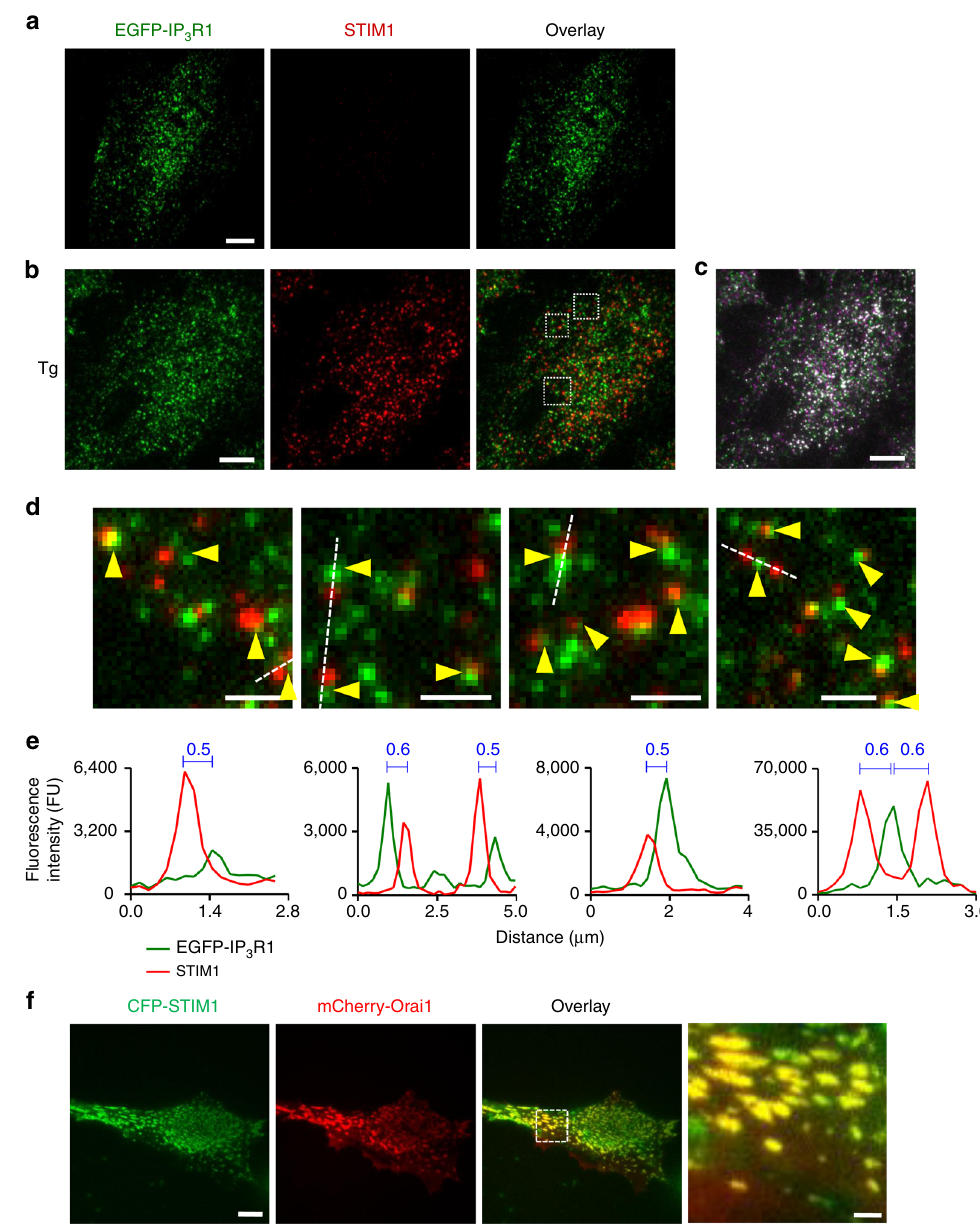
Fig. 7 Depletion of ER Ca 2+ stores causes native STIM1 to accumulate at functional ER-PM junctions adjacent to immobile IP 3 R puncta. a , b Representative TIRFM images of EGFP-IP 3 R1 HeLa cells fi xed and immunostained for STIM1 before ( a ) or after treatment with thapsigargin (Tg, 1 µ M, 15 min) to deplete the ER of Ca 2+ ( b ). Overlaid images of Tg-treated cells show no signi fi cant co-localization of STIM1 and IP 3 R puncta (Pearson ’ s coef fi cient with Costes ’ automatic threshold: 0.331 ± 0.026, n = 7 cells). c Distribution of mobile (green and magenta) and immobile (white) IP 3 R puncta in Tg-treated cell. Scale bars ( a – c ) = 10 µ m. d Enlargements of the boxed regions in b show that immobile IP 3 R puncta (identi fi ed before fi xation ( c ), with all shown by arrowheads) abut STIM1 puncta without coinciding with them. Scale bars = 2 µ m. e Fluorescence intensity pro fi les for EGFP-IP 3 R1 and STIM1 across the lines shown in d . Distances ( μ m) between the peaks of the fl uorescence intensity for STIM1 and immobile IP 3 R are shown. f Co-localization of CFP-STIM1 (pseudocoloured green) and mCherry-Orai1 (red) puncta in a Tg-treated HeLa cell. We used tagged proteins because available antibodies do not reliably detect endogenous Orai1. Scale bar = 10 µ m (2 μ m in